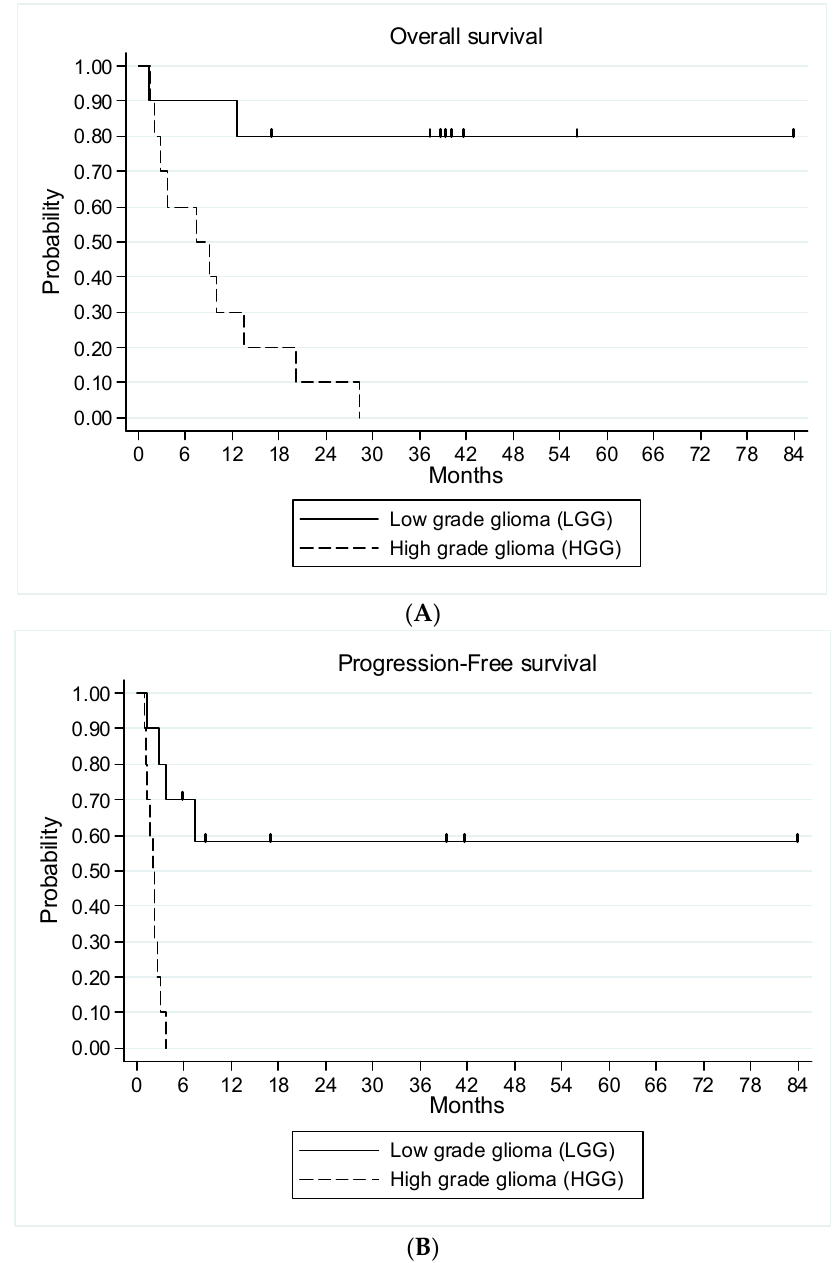
Figure 4. Kaplan–Meier curves for overall survival ( A ) and progression-free survival ( B ) of all 20 patients according to the type of glioma.